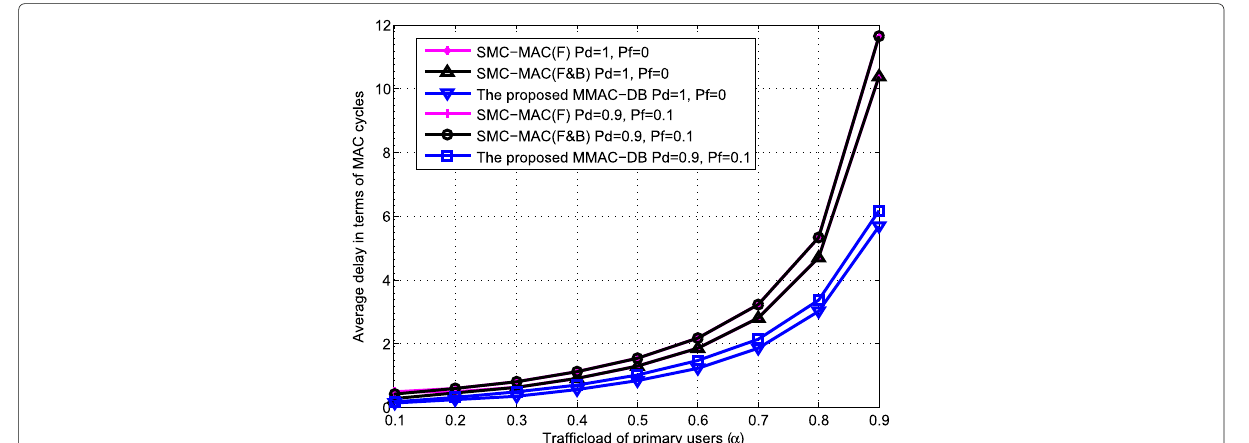
Fig. 8 Channel access delay comparison with varying PU traffic load, N = 20, M = 20, K f = 50. Channel access delay comparison for scene